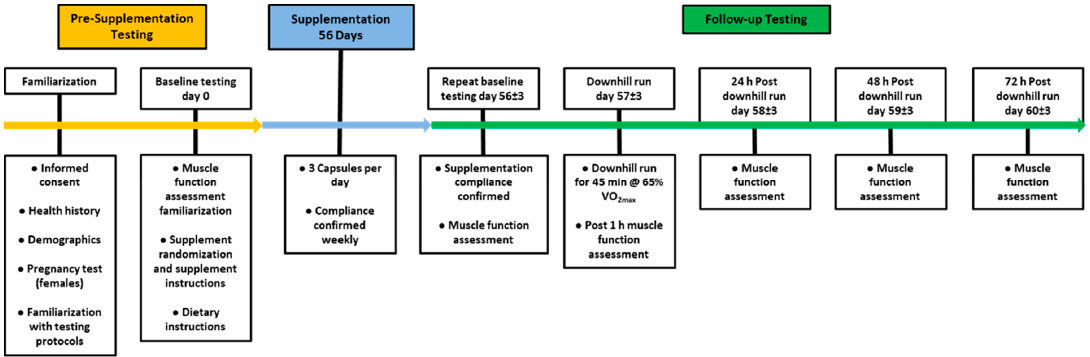
Figure 1. Study Design. Measurements are noted along the time line.